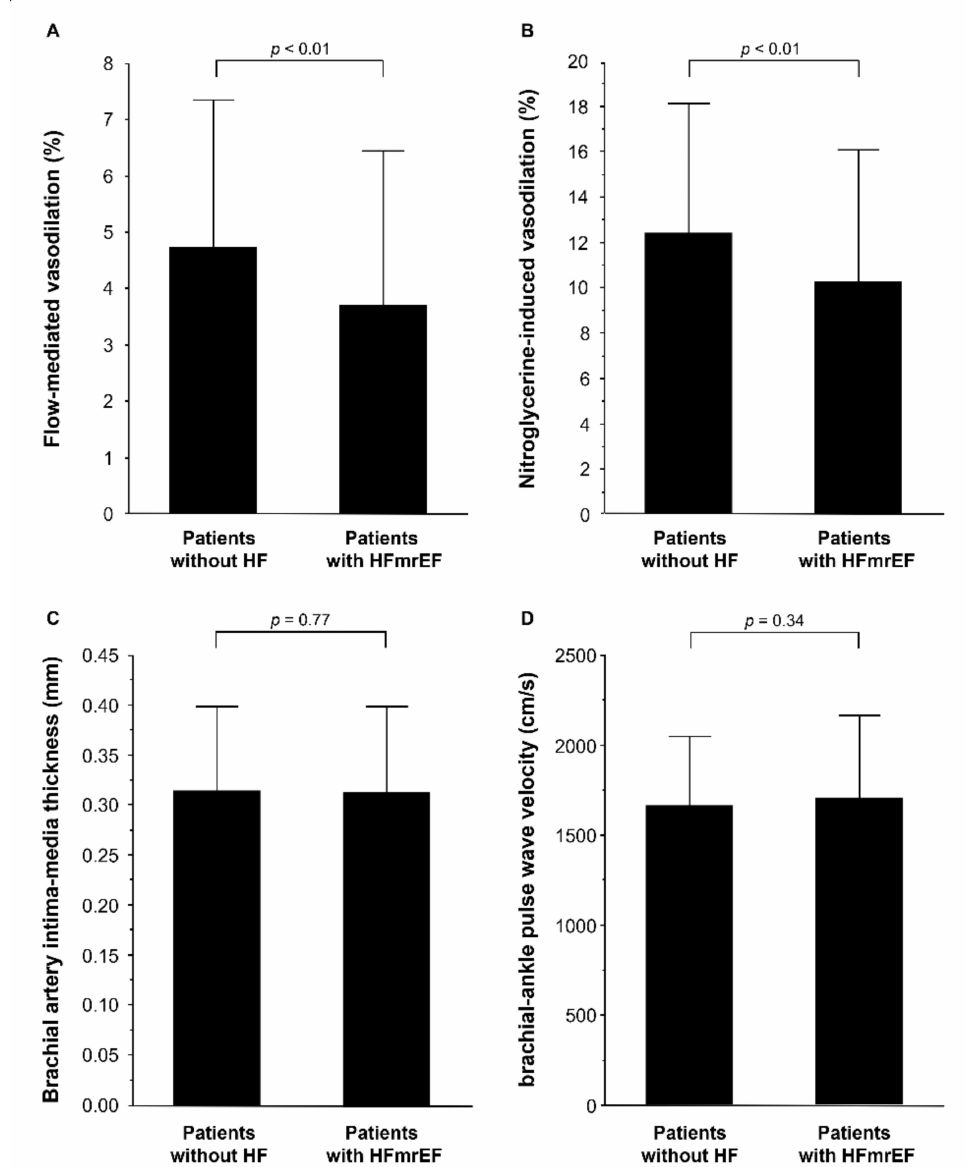
Figure 1. Bar graphs show flow-mediated vasodilation ( A ); nitroglycerine-induced vasodilation ( B ); brachial intima-media thickness ( C ), and brachial–ankle pulse wave velocity ( D ) in patients without heart failure (HF) and patients with heart failure with mildly reduced ejection fraction